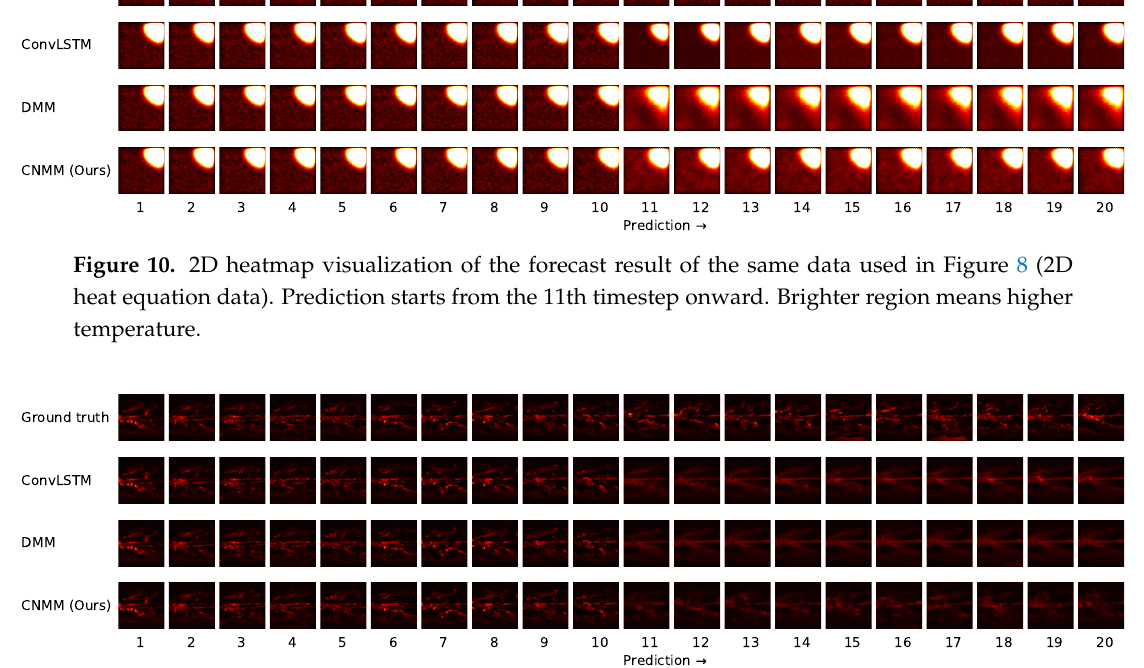
Figure 11. 2D heatmap visualization of the forecast result of the same data used by Figure 9. As with Figure 10, prediction starts from 11th timestep and brighter region means higher precipitation